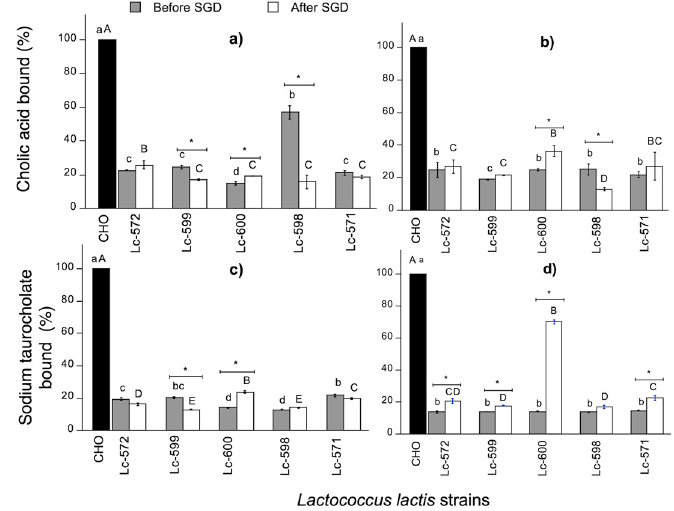
Figure 5. Cholic acid ( a , b ) and sodium taurocholate salt ( c , d ) binding (%) relative to cholestyramine by WSF from fermented milk with 24 and 48 h fermentation, before and after simulated gastrointestinal digestion (SGD). Different letters represent significant differences ( p < 0.05) among strains before (lowercase, a – d) and after (uppercase, A – E) SGD for the same time. Asterisk (*) represents significant differences ( p < 0.05) before and after SGD. Data are average (± SD) of triplicate samples. CHO: Cholestyramine.